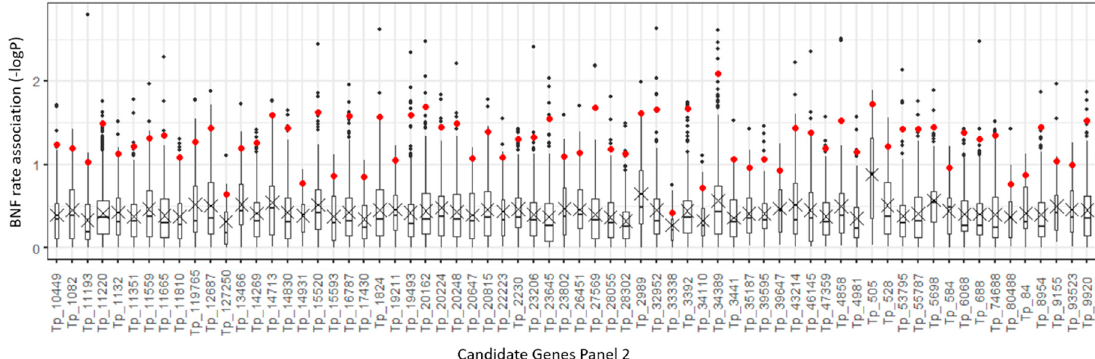
Figure 3. Boxplot of − logP association values for Panel 2 of nitrogen fixation candidate gene polymorphisms based upon a mixed linear model incorporating both population structure and relationship between accessions. Red dots show mean values for the 10 highest − logP values of each associated polymorphism. The highest mean value was for Tp_34389, which is the sequence carrying the molybdate transporter type 1 ( MOT1 ) gene [35].